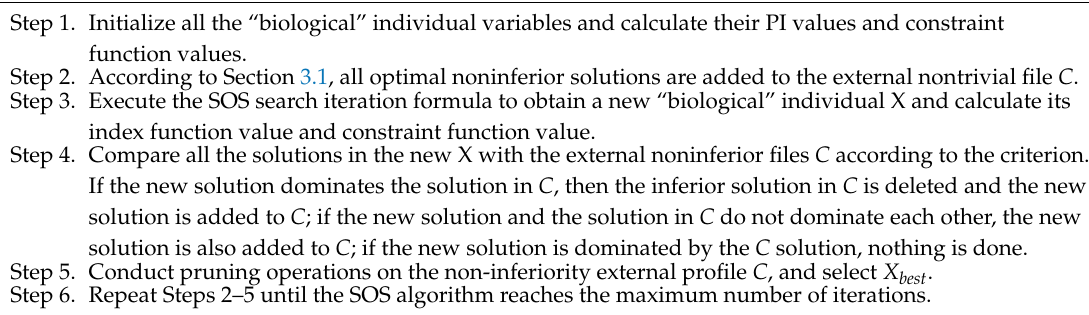
Algorithm 1: Algorithm of the optimal solution selection.